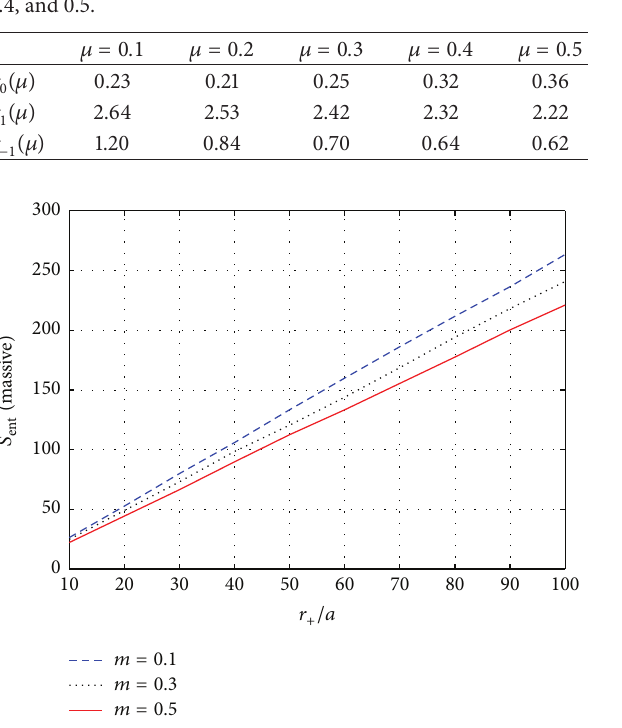
,𝑐 , and 𝑐 − for different masses 0.1, 0.2, 0.3, 0 1 1